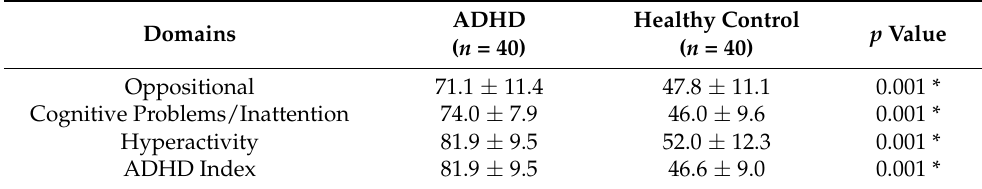
Table 4. Comparison of Conners’ Parent Rating Scale—Short version (Revised) domains between ADHD and control group.